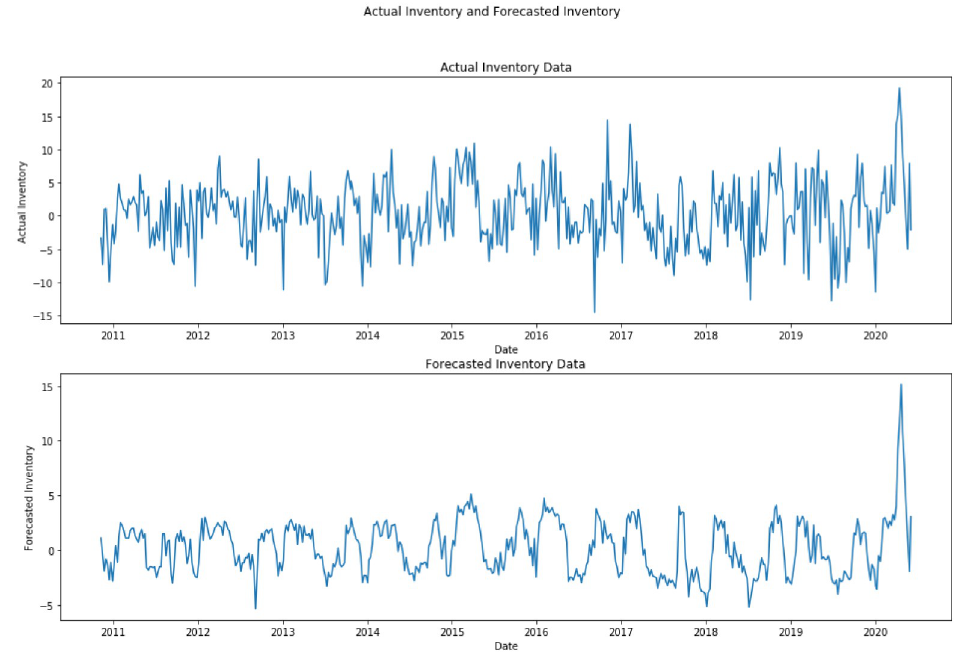
Fig 5. This diagram shows actual inventory and forecasted inventory on a weekly basis from 2011 to